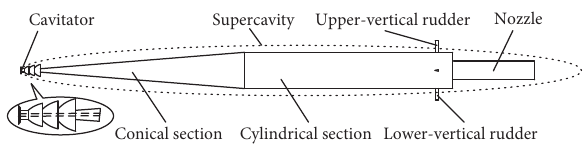
Figure 1: Schematic diagram of